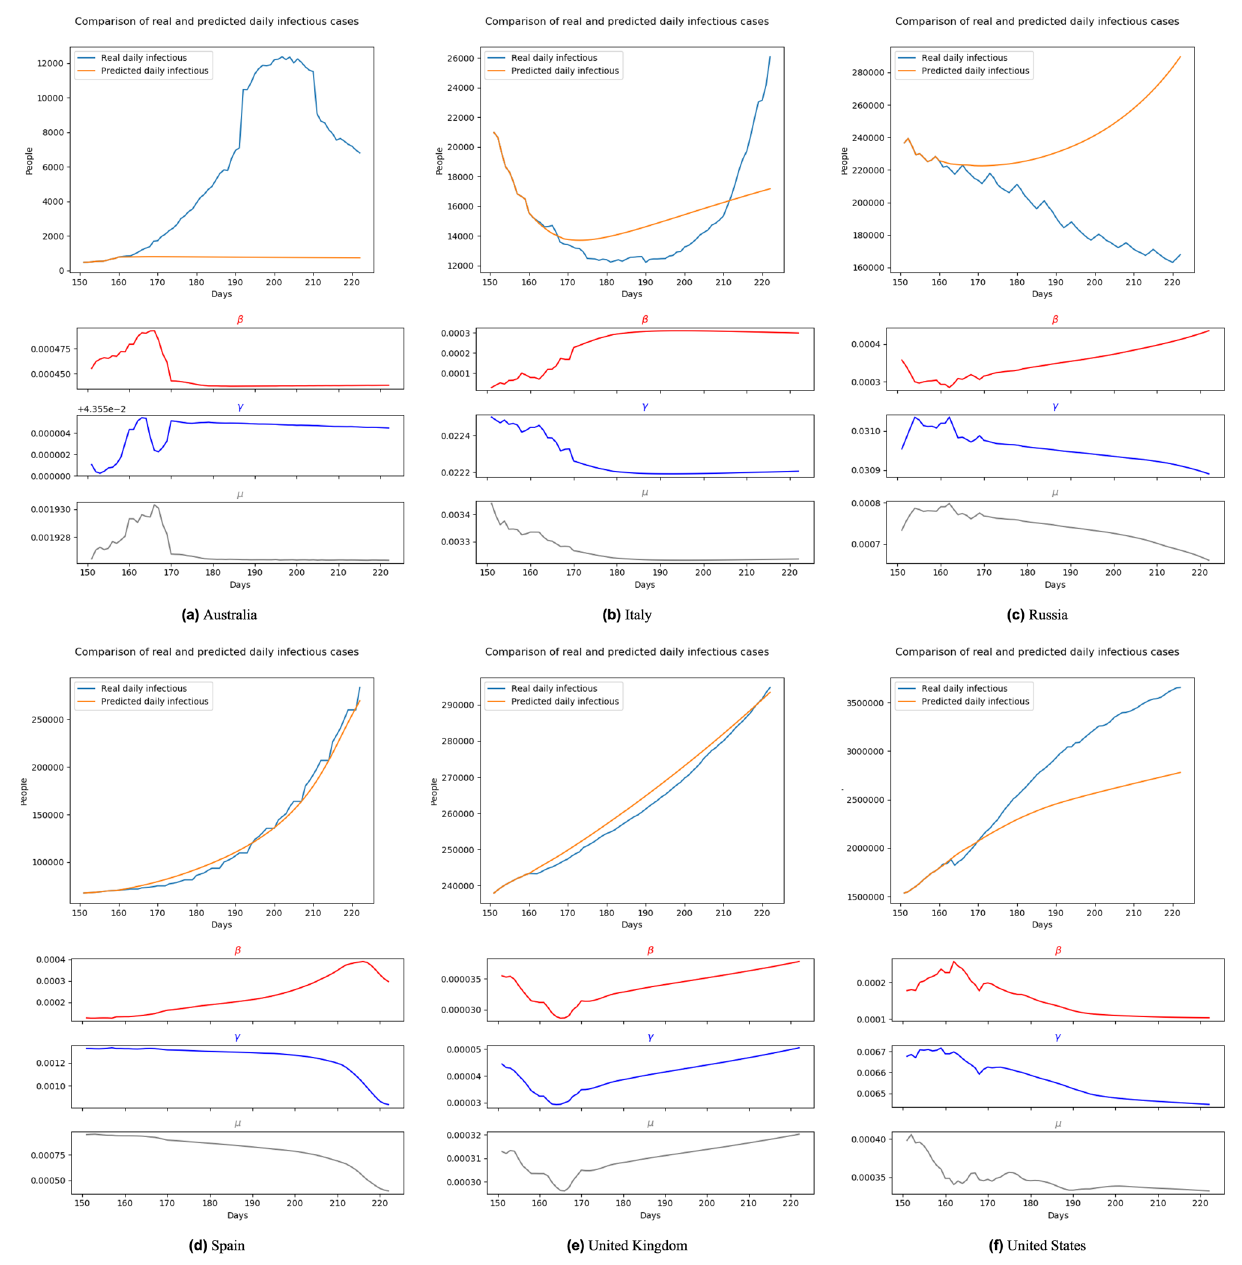
Figure 10. Forecasting results with transition rates of 161th–222nd day (Jul. 1st 2020–Aug. 31st 2020) using data of 151st–160th day (Jun. 21st 2020–Jun. 30th